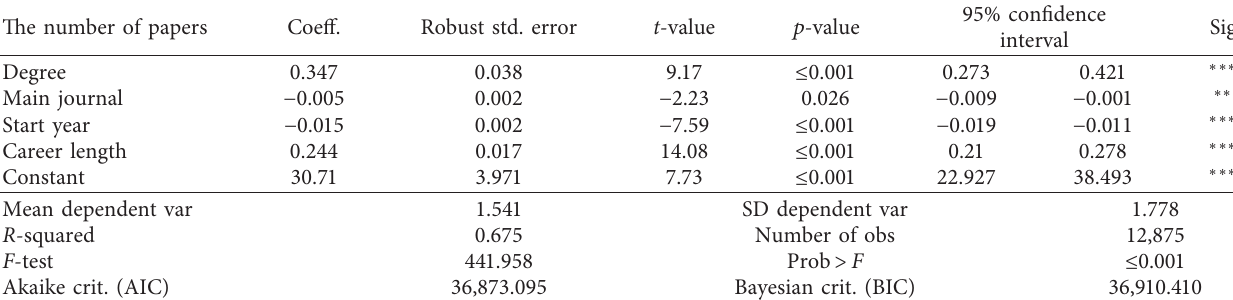
Table 2: Unary linear regression results of the number of papers and degree centrality.